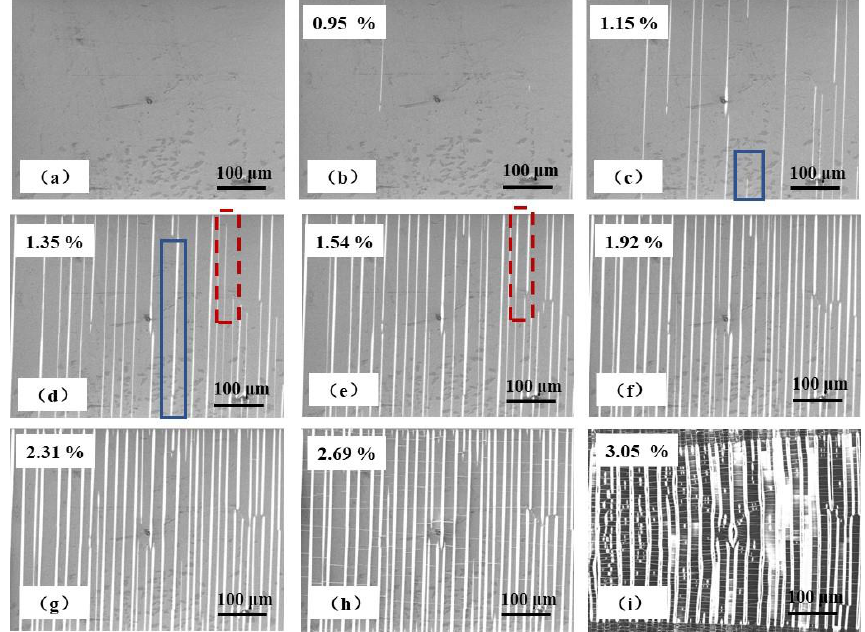
Figure 4. Typical process of crack initiation, propagation, saturation and delamination in 50 nm ITO film on PC. ( a ) and ( b ) were stage I, crack initiation; ( c ), ( d ) and ( e ) were stage II, crack propagation; ( f ), ( g ), ( h ) and ( i ) were stage III, crack saturation and delamination.